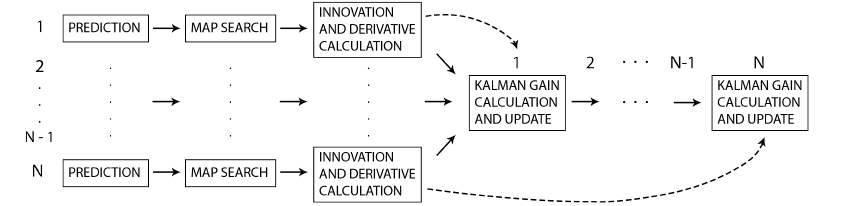
Figure 6. Parallel-serial algorithm. Algorithm 4: Parallel-serial Kalman